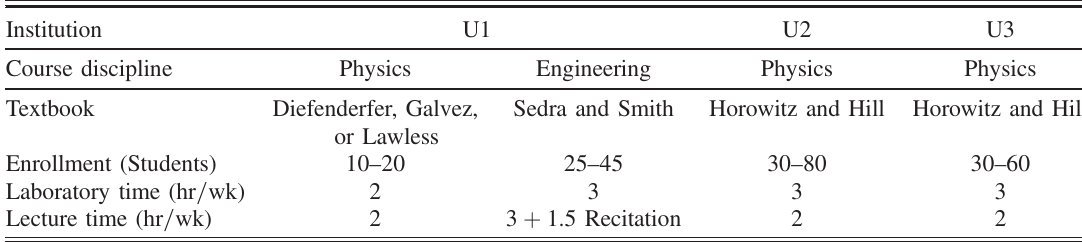
TABLE I. Overview of courses in which data were